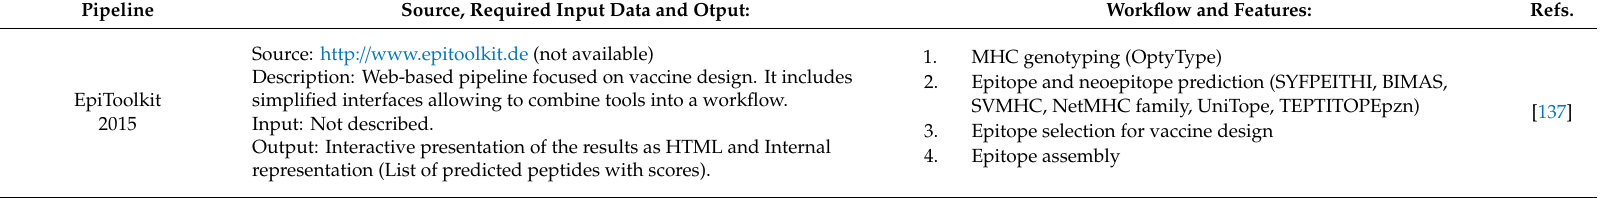
Table 1. The list of currently available computational pipelines for neoantigen prediction *